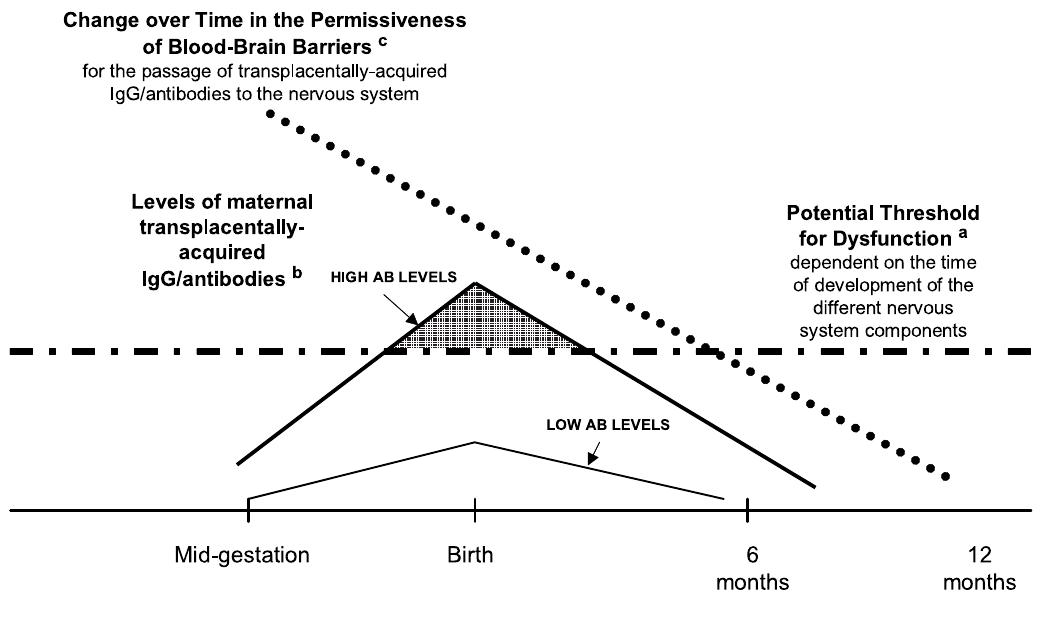
Figure 3. A model depicting the WINDOW for high or low levels of transplacentally-acquired IgG/antibodies to cause NMDs in relation to: (1) development over time of neurological components and/or functions; (2) change over time in the permissiveness of Blood–Brain–CSF- Barriers; and (3) a potential threshold for the development of dysfunction with time, dependent on genetic, epigenetic and postnatal environmental